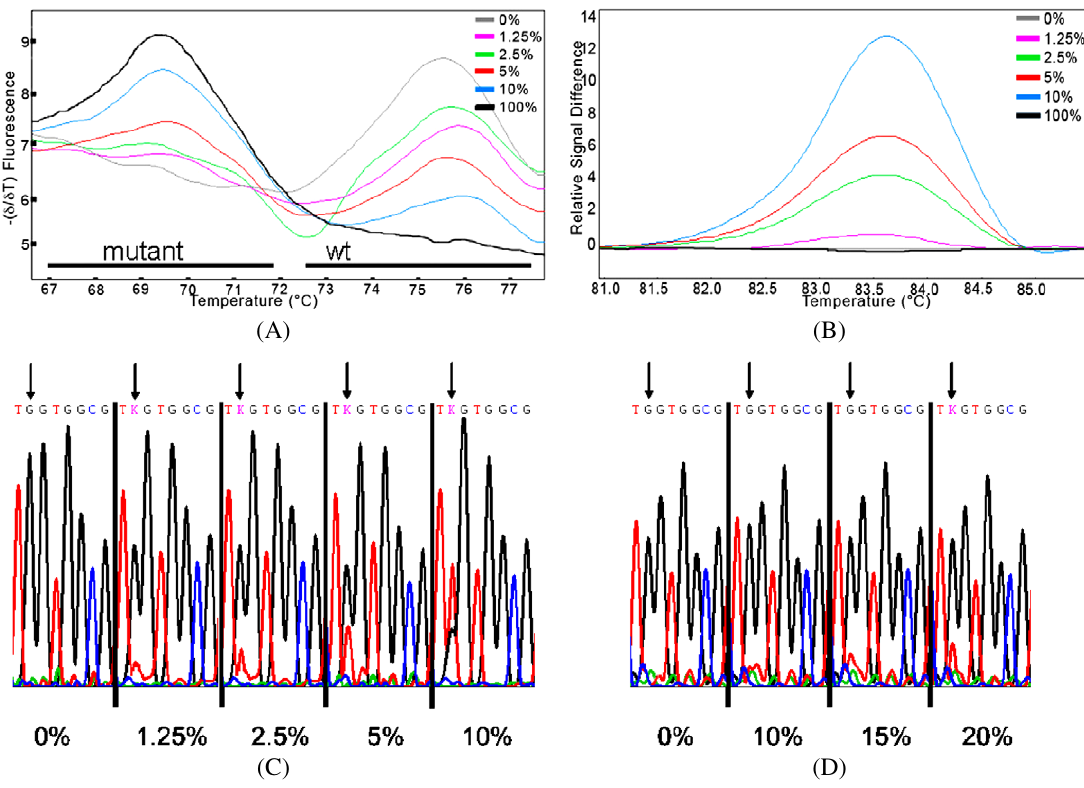
Fig. 1. HRM assay for K-ras exon 1. The designed HRM assay encompasses a pre-screening approach. The HRM assay is based on an asym- metrical PCR with an unlabelled wild-type probe in the presence of a fluorescent intercalating DNA dye with subsequent melting analysis of both PCR amplicons and amplicon-probe duplexes. The pre-screen assay may be followed by direct sequencing of HRM PCR products showing an aberrant melt out to reveal K-ras exon 1 genotype. Shown are representative HRM assay findings on a dilution series of Calu-1, containing a homozygous G12C mutation (i.e., 0, 1.25, 2.5, 5, 10 and 100% indicated by grey, purple, green, red, blue and black lines, respectively) in a background of WT-DNA. (A) The separation of the probe is examined in the first melting range (Melt 1: 55–78 ◦ C). The probe melts off at a lower temperature (i.e., 68–72 ◦ C) when a mutation is present as compared to WT (i.e., 74–78 ◦ C). Due to the WT-sequence of the probe, besides heterozygous mutations also homozygous mutations are detected (see black line of 100% Calu-1 DNA). (B) The normalised and temperature shifted melting plot is used to best visualise the difference in melt out of amplicons (Melt 2; melting range: 78–95 ◦ C). The relative signal differ- ence as compared to a reference WT-DNA (indicated in grey) indicates the level of altered melting of amplicons. (C) The pre-screen assay may be followed by direct sequencing of HRM PCR products showing an aberrant melt out to find out the nature of the K-ras mutation. Representative examples of 0, 1.25, 2.5, 5, 10% Calu-1 DNA in WT-DNA background are shown. (D) Direct sequencing of conventional nested-PCR products. Representative examples of 0, 10, 15, 20% Calu-1 DNA in WT-DNA background are shown. Note : Colours available in the web version